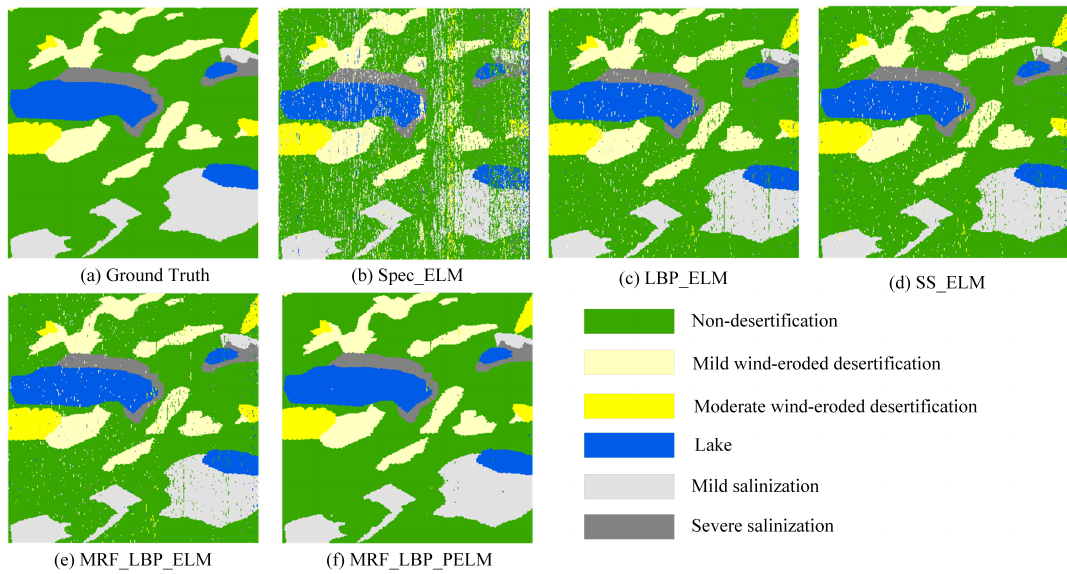
Figure 11. Comparison of visual interpretation results of different methods on saline areas